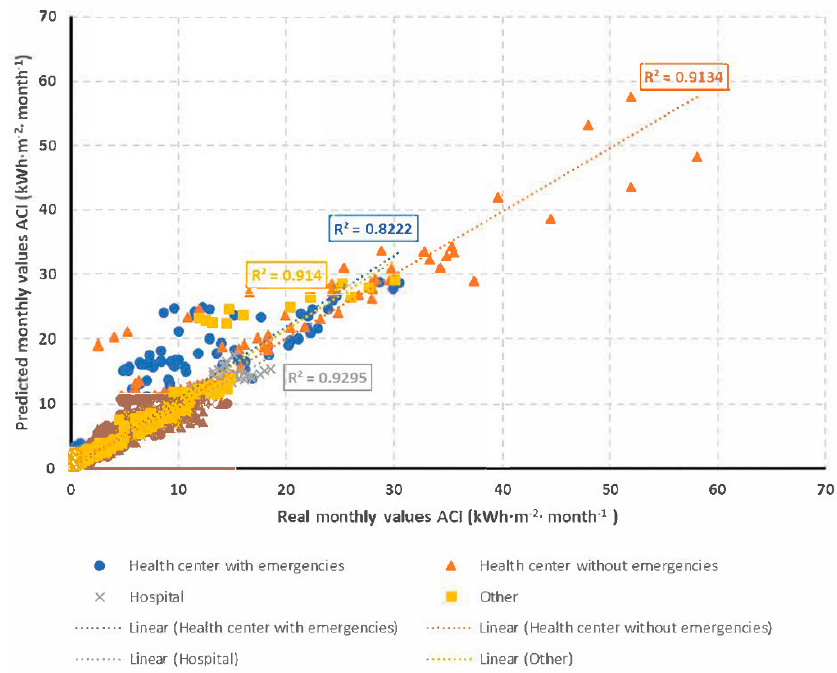
Figure 7. Correlation for each building type of the modeled values and the real data.